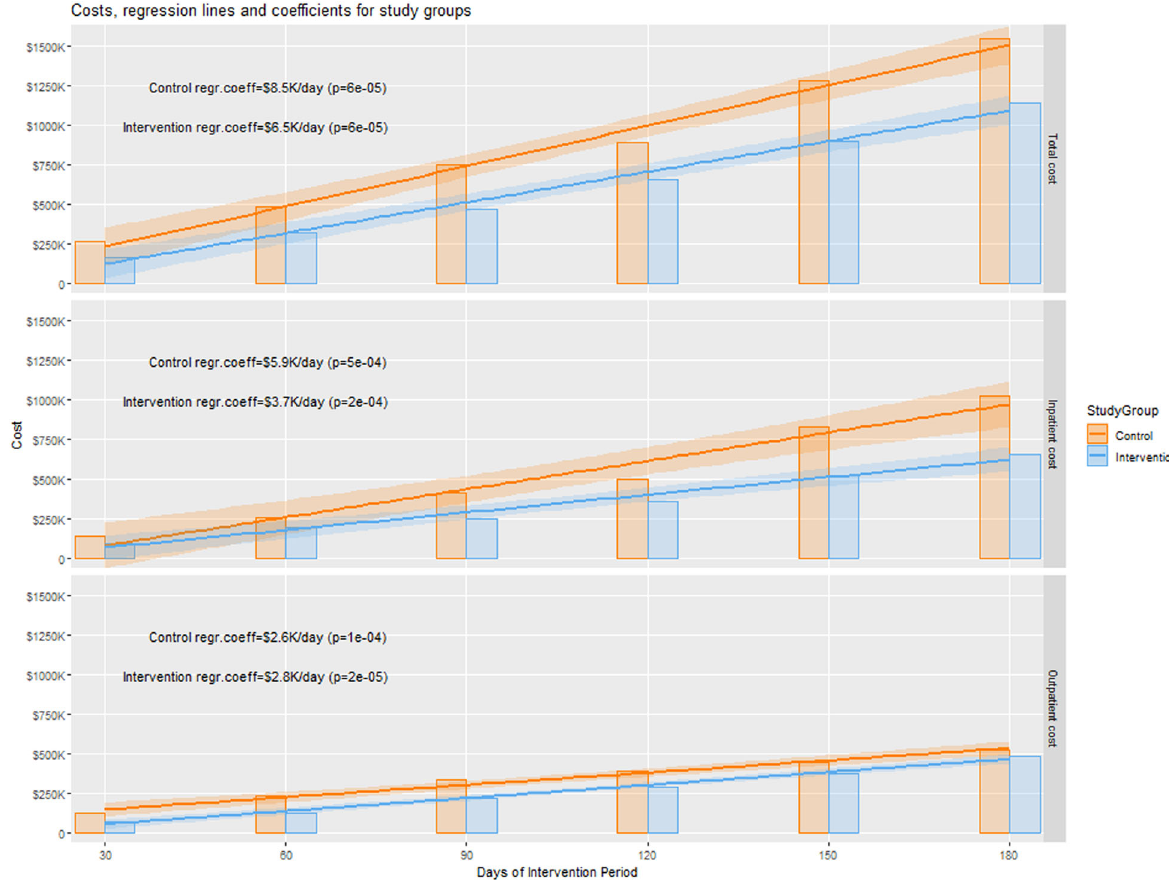
Fig. 2 Healthcare cost results within each group. Illustrates the regression lines and coef fi cients (lines slopes) for each study group. The regression coef fi cients indicate the expected daily cost increase in each group for the accumulated total, inpatient and outpatient healthcare costs in the top, middle, and bottom panels,